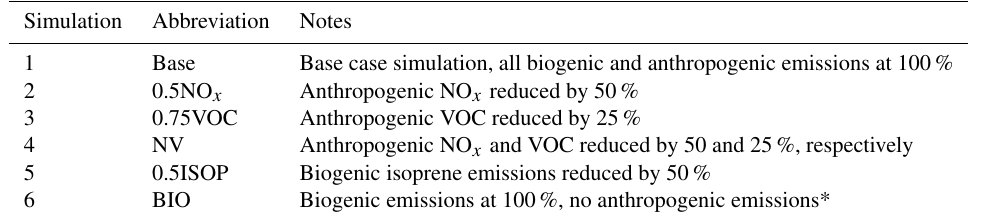
Table 4. Settings for sensitivity simulations.